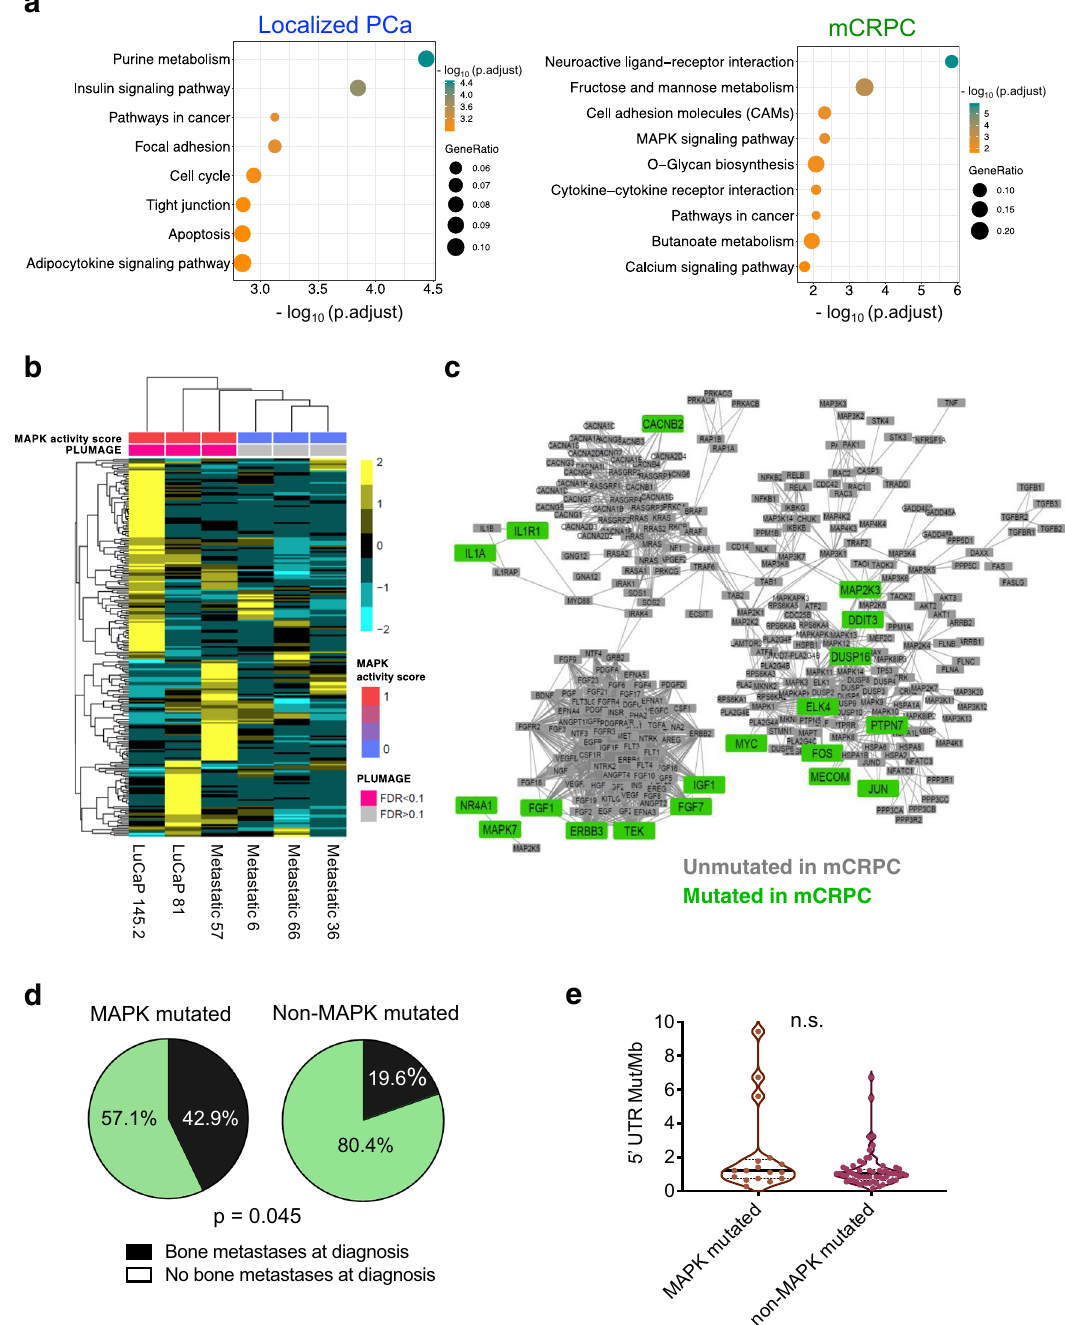
Fig. 7 5 ′ -UTR mutations in MAP kinase signaling pathway genes associated with increased pathway activity and metastases in prostate cancer patients. a Genes with 5 ′ -UTR mutations in localized and advanced prostate cancer cluster into distinct functional categories as determined by KEGG pathway analysis (Fisher ’ s hypergeometric test, FDR < 0.05). b Heatmap of a MAP kinase pathway activity signature demonstrating that patients with functional 5 ′ -UTR mutations to MAP kinase regulators (PLUMAGE FDR < 0.1) exhibit increased pathway activation compared to nonfunctional mutations (PLUMAGE FDR > 0.1). The heatmap color key represents normalized log 2 (CPM + 1) values for each gene. c Metastatic castration-resistant prostate cancer patients harbor 5 ′ -UTR mutations within genes found in the MAP kinase signaling pathway. Gene names in green represent those with 5 ′ -UTR mutations in mCRPC patients. Gene names in gray are MAP kinase signaling pathway components and downstream effectors that are not mutated in mCRPC patients. d mCRPC patients with mutated MAP kinase pathway genes are signi fi cantly more prone to bone metastases at diagnosis (black) compared to patients who do not harbor these mutations (green) ( p = 0.045, two-sided Student ’ s t test). e The difference in bone metastasis at diagnosis between the two patient groups is independent of any differences in 5 ′ -UTR tumor mutational burden (n.s. not statistically signi fi cant, two-sided Student ’ s t test). Source data are provided as a Source data fi